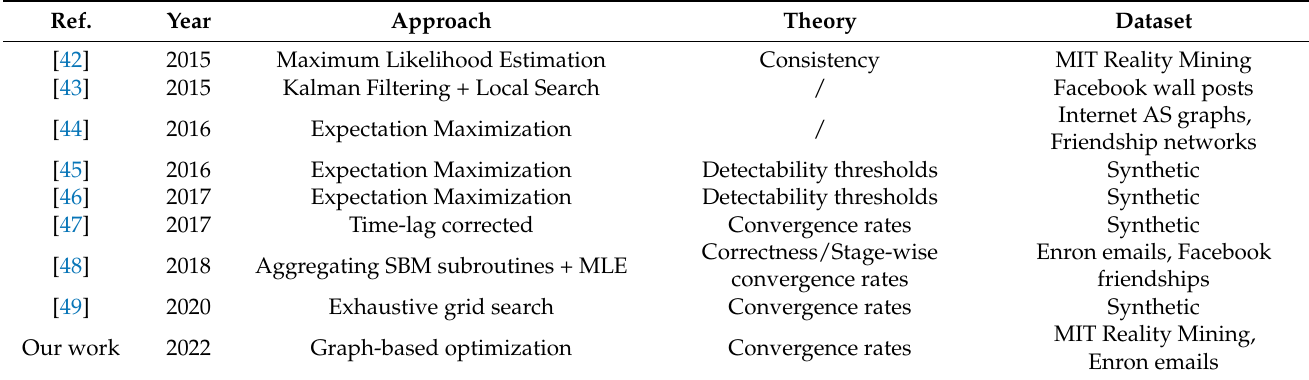
Table 1. Comparison of our work with previous model literatures.